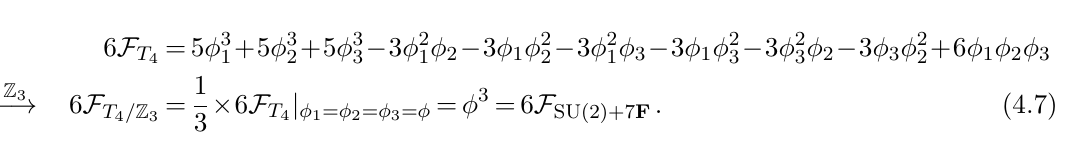
Figure 22 . The Z 3 quotient of T 5 theory. We insert A 5 BCB at the vertex connected to the (1 , − 1) 5-brane line. This leads to a 7-brane configuration for SU(3) has an SO(20) flavor